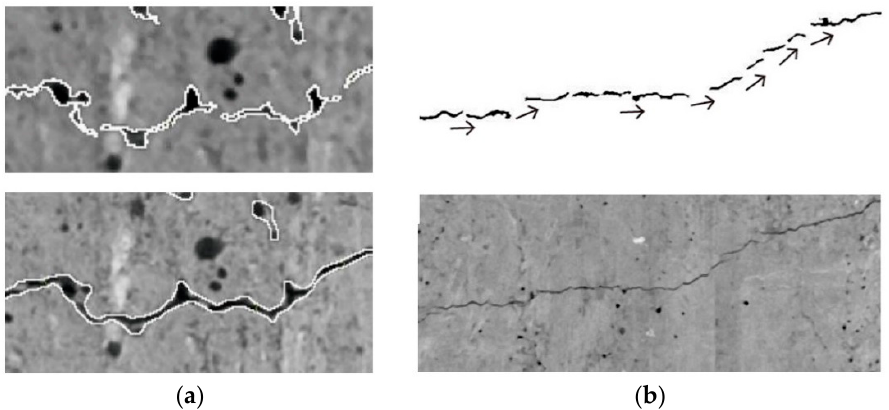
Figure 11. Growth pattern of cracks detection: ( a ) proximity between segments of a crack reveals its growth pattern; and ( b ) final path of the measured crack tells about the loading pattern.